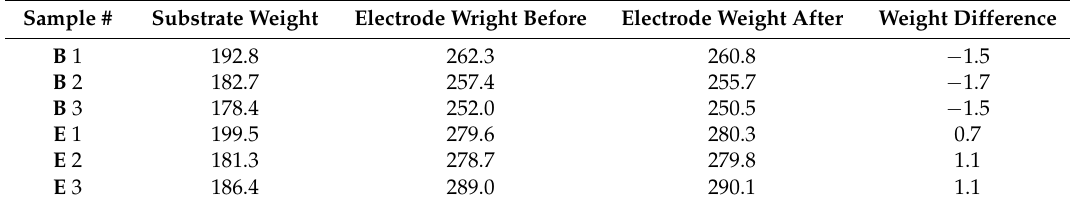
Figure 9. Weight changes after KOH-etching for three electrodes from B (left) and three from E (right). Table 3. Measurement of weight change before and after KOH-etch for A and B . All numbers are in mg. Sample #